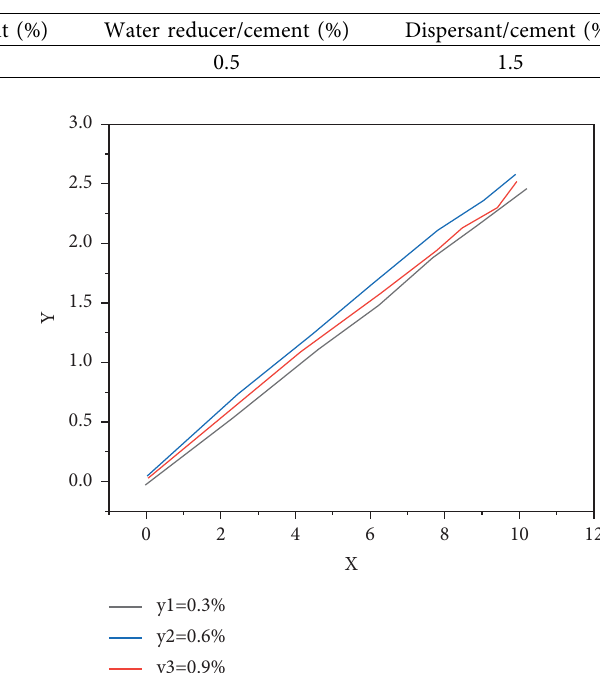
Table 4: Mass ratio of CFRC materials.